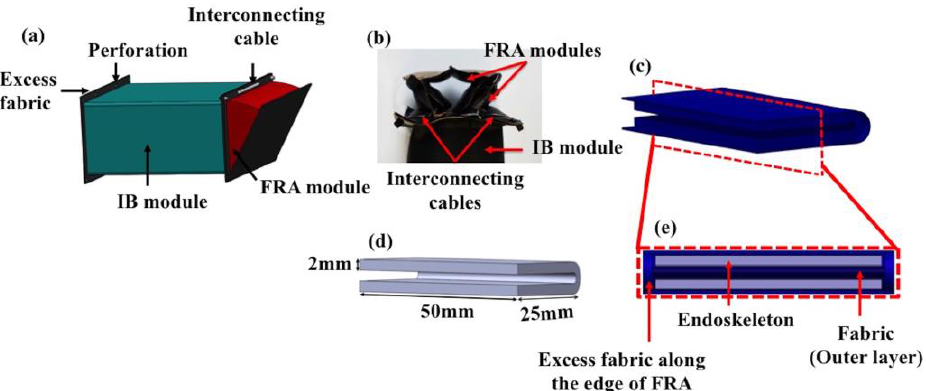
Figure 1. ( a ) Illustration of the fabric-based rotary actuator (FRA) and inflatable beam (IB) module assembly, ( b ) Photo of end-effector to illustrate the connection of FRA and IB modules, ( c ) FRA module in inactive state, ( d ) Ninjaflex endoskeleton, and ( e ) enlarged cross-sectional view of FRA with internal Ninjaflex endoskeleton.